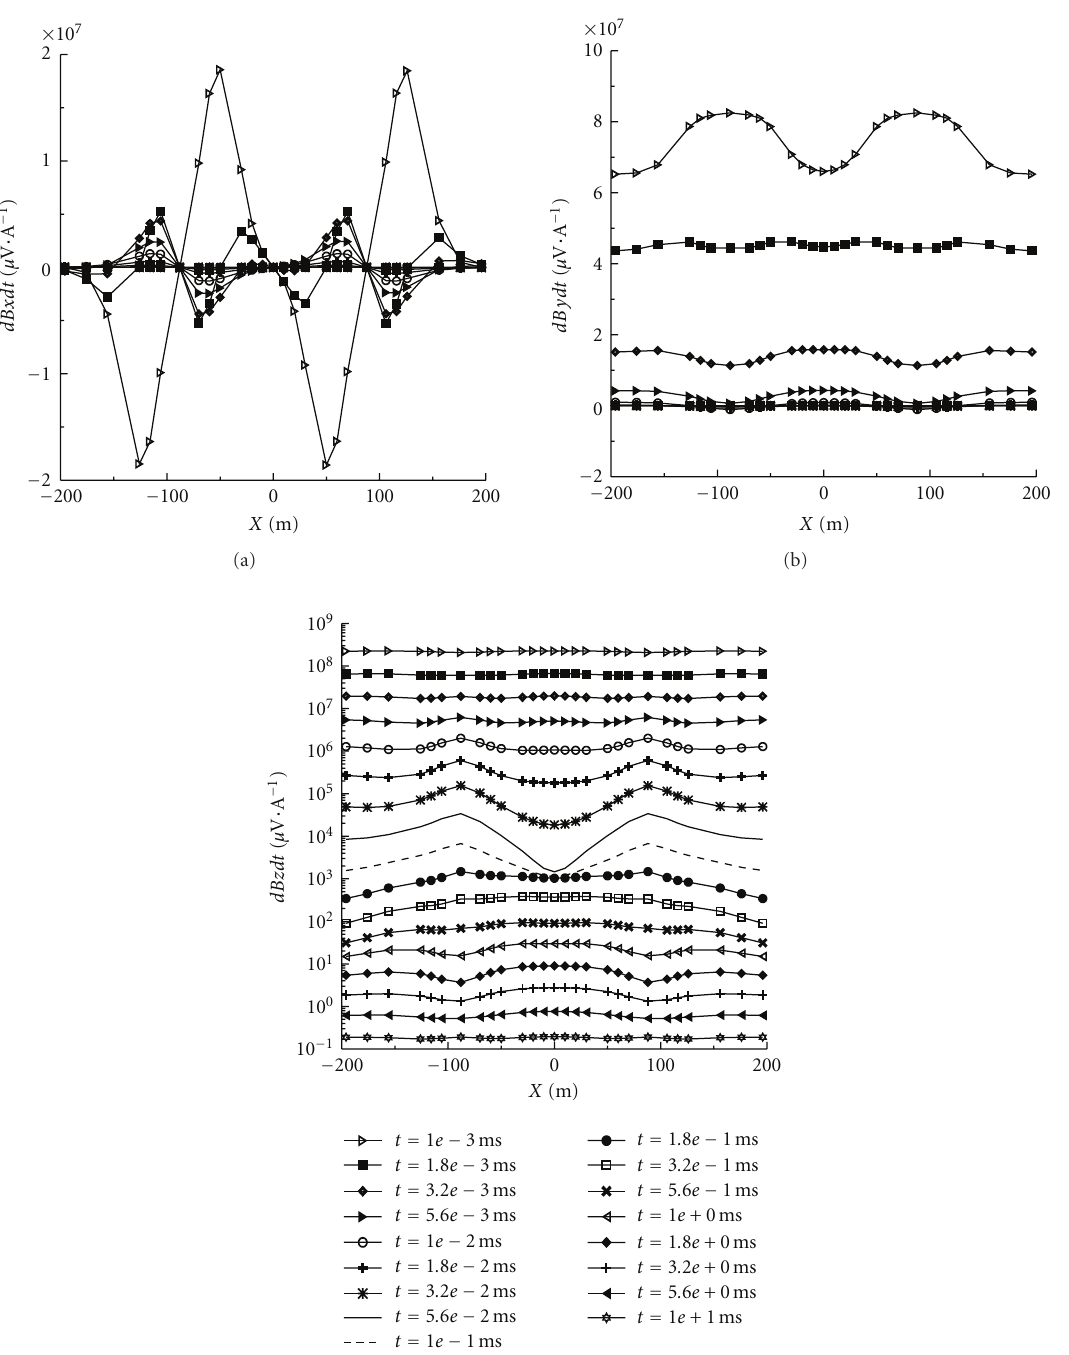
Figure 6: TEM profiles of compound orebody for (a) the horizontal EMF in x direction, (b) the horizontal EMF in y direction, and (c) the vertical